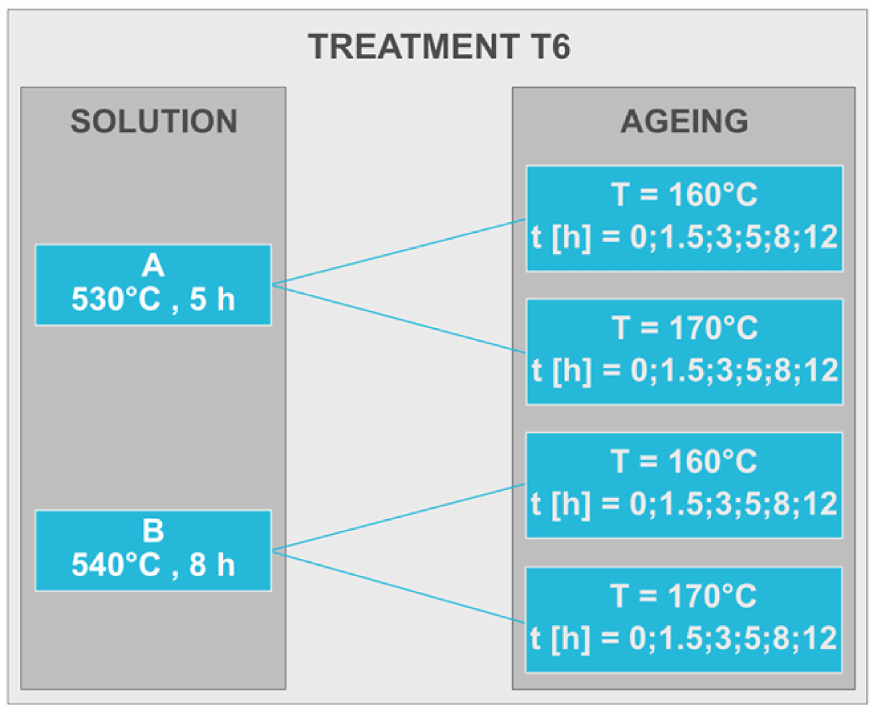
Figure 2. The di ff erent T6 treatment conditions investigated on A357 alloy by